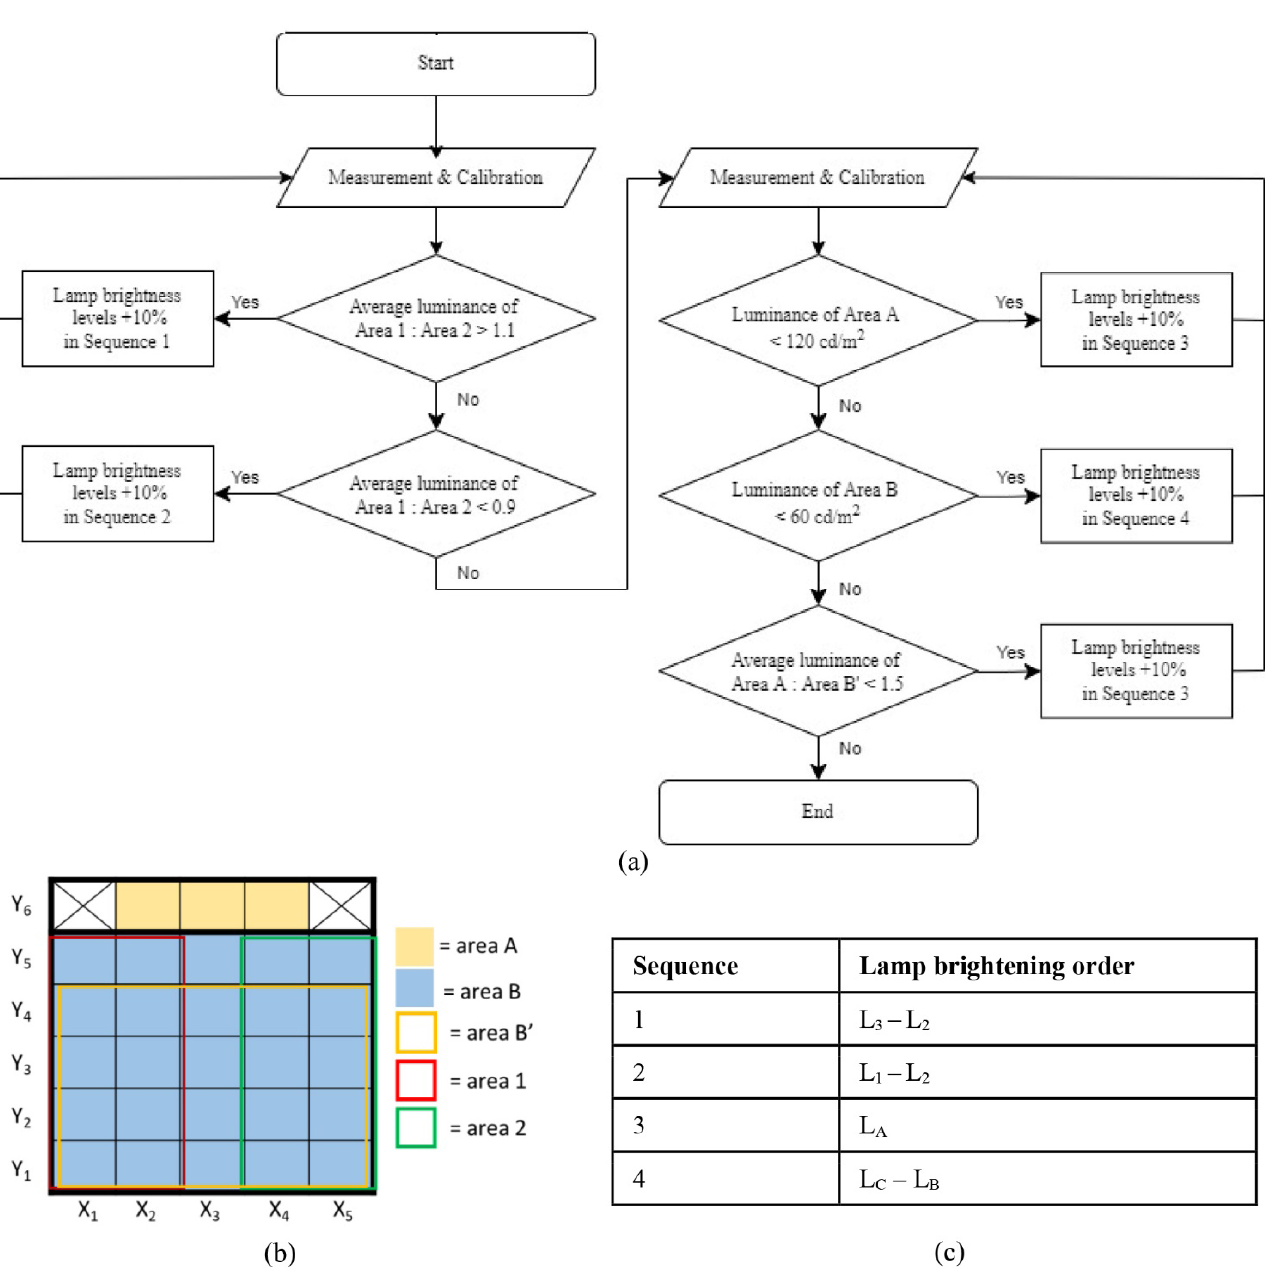
Figure 7. ( a ) The LCS flow diagram for scheme 2; ( b ) The layout of the room; ( c ) The sequence of the lamps brightened.